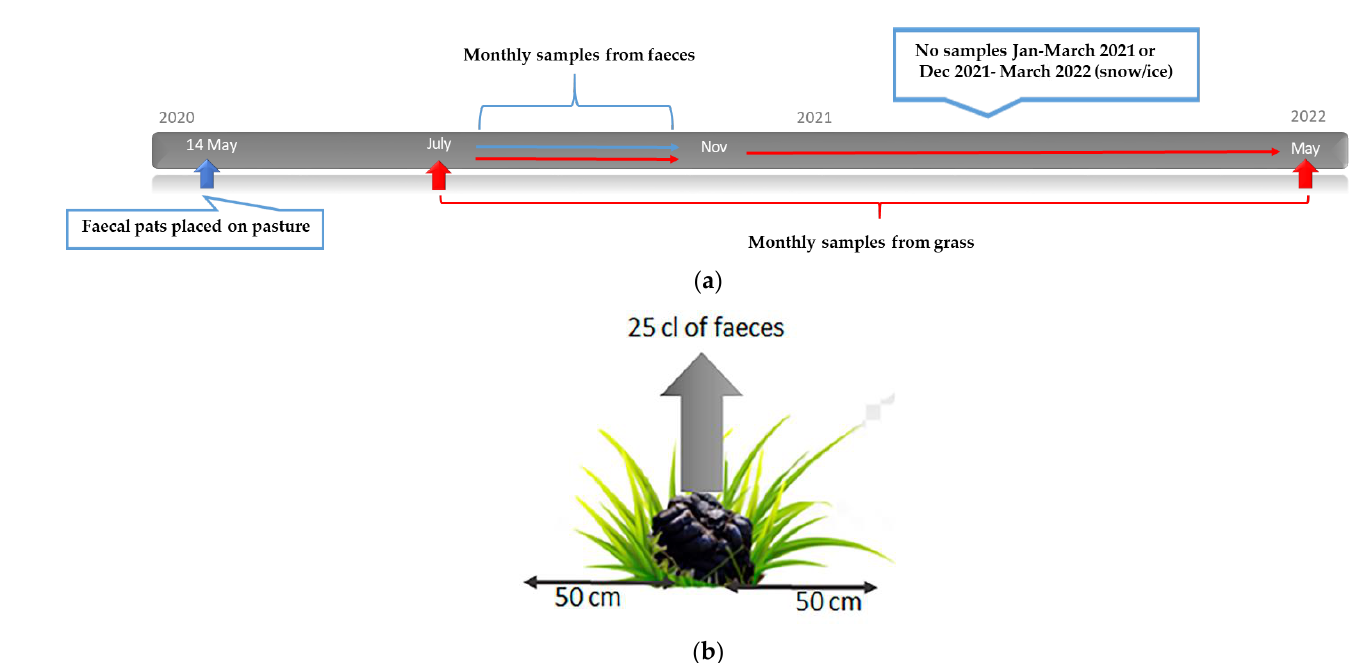
Figure 5. Overwintering study, 2020 – 2022: ( a ) Faecal pats (in total 20 pats) were placed on a parasite-free pasture on 14 May 2020. Faecal samples for harvesting L3 were collected every month from July – November 2020 and grass samples for harvesting L3 were collected every month from July 2020 until May 2022, apart from when the ground was covered with snow or ice. ( b ) A pinch of grass, approximately 0.5 cm in diameter, was cut from ten evenly distributed places within a 50 cm diameter zone of each pat during each month of the study period. In addition, for the first five months, faecal samples (25 cl) were obtained every month.